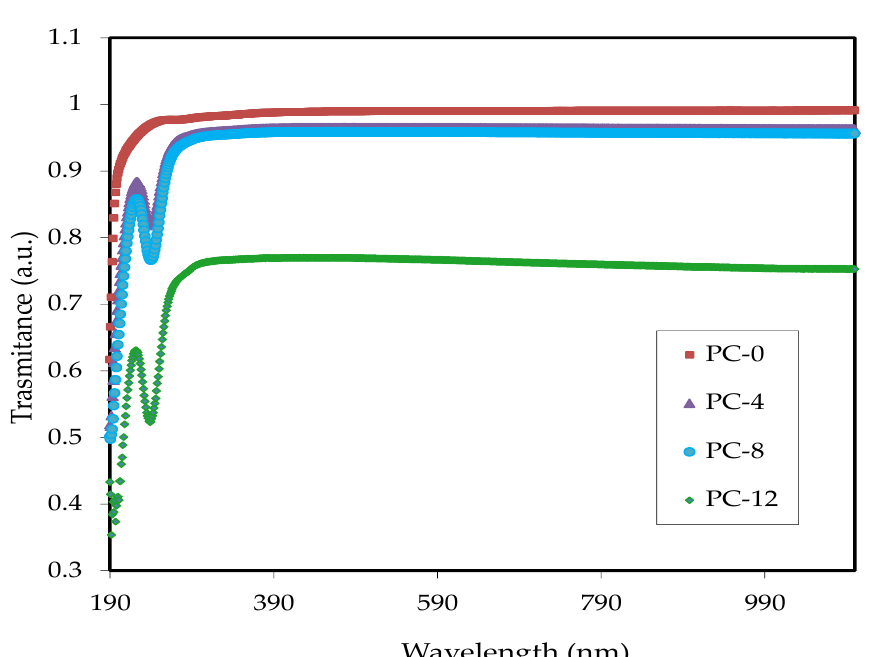
Figure 2. FTIR spectra associated with PVA/PbSNCPs and PVA.